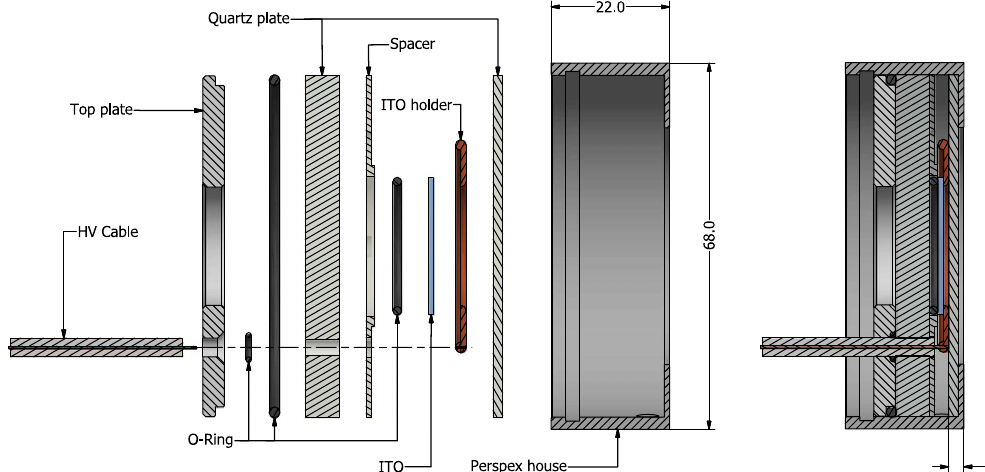
FIG. 4. Cross-sectional view of the accelerator module. Left: Breakout view of the accelerator module. Right: Assembled module. The transparent ITO electrode is connected to a copper electrode ring (ITO holder) using conductive epoxy. The copper ring is connected to a HV power supply. The electrode is sandwiched between two quartz plates.